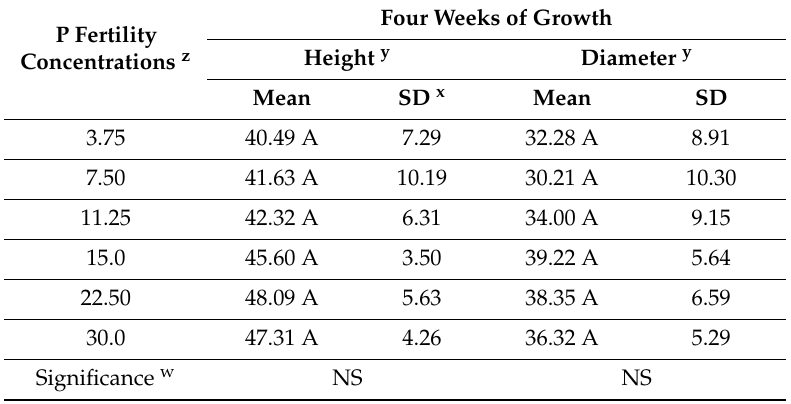
Table 1. The impacts of phosphorus (P) fertility on plant growth metrics of C. sativa “BaOx” after four weeks of vegetative